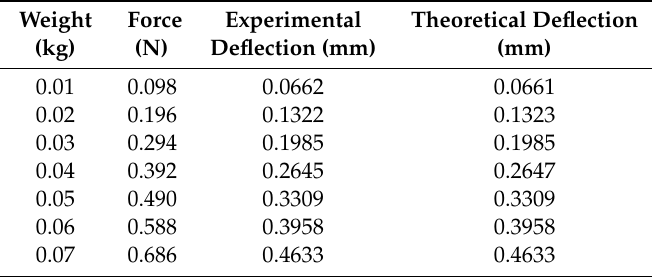
Table 5. Experimental and theoretical results of weight-related force and deflection without VCA.